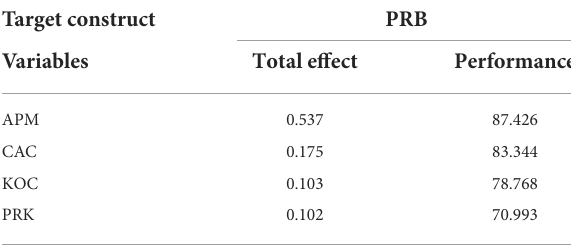
TABLE 12 Importance-performance